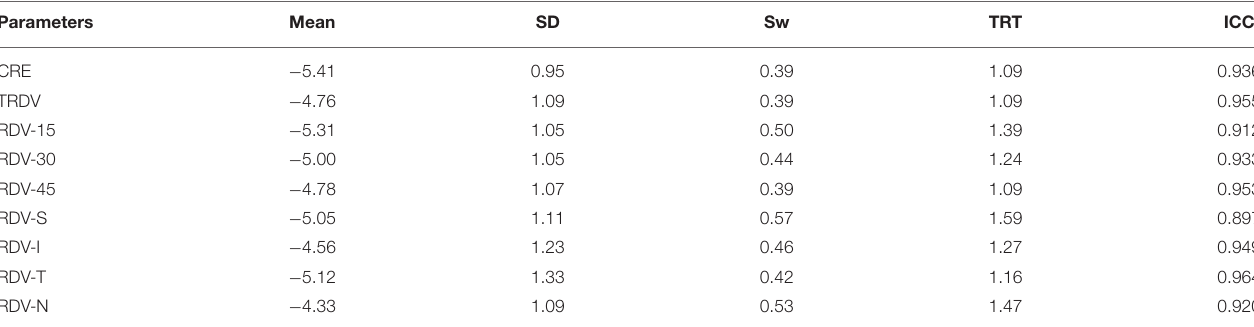
TABLE 4 | Intraobserver repeatability outcomes of central and peripheral refraction using MRT without cycloplegia of moderate myopia group.